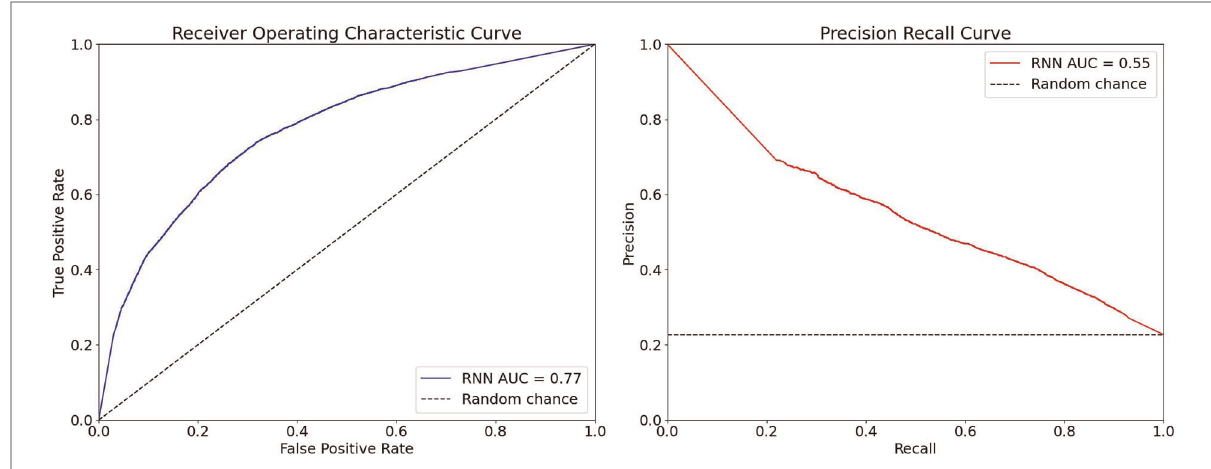
FIGURE 4 ROC and PRC results for the RNN autoencoder on mortality classi fi